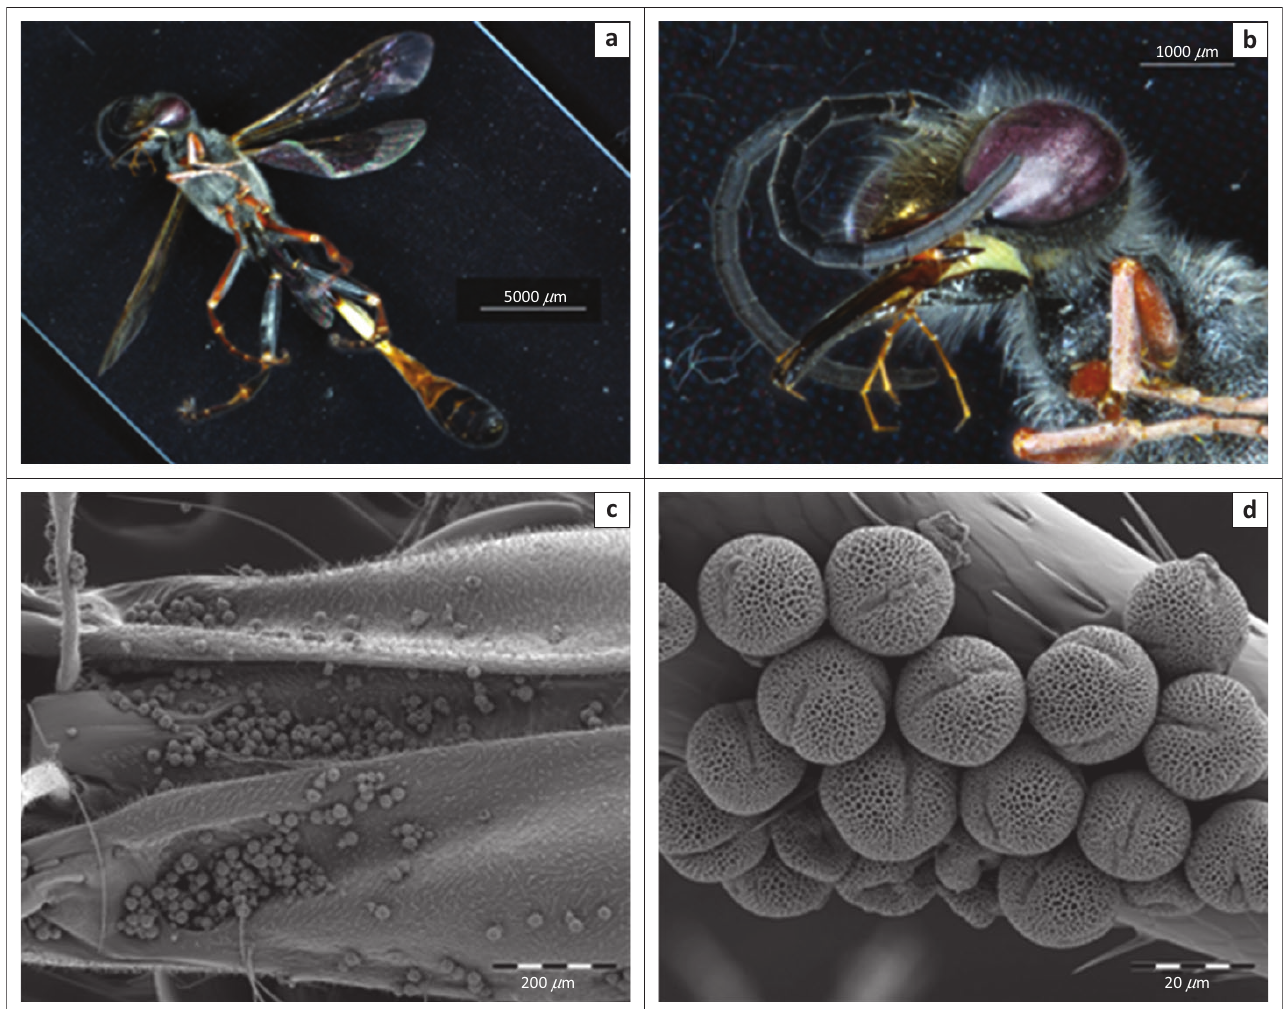
FIGURE 7: (a, b) Stereomicrographs of Ammophila sp. (Sphecidae). Scanning electron micrographs of Frithia humilis pollen grains on the underside of the mouth parts (c) and on a maxillary palp